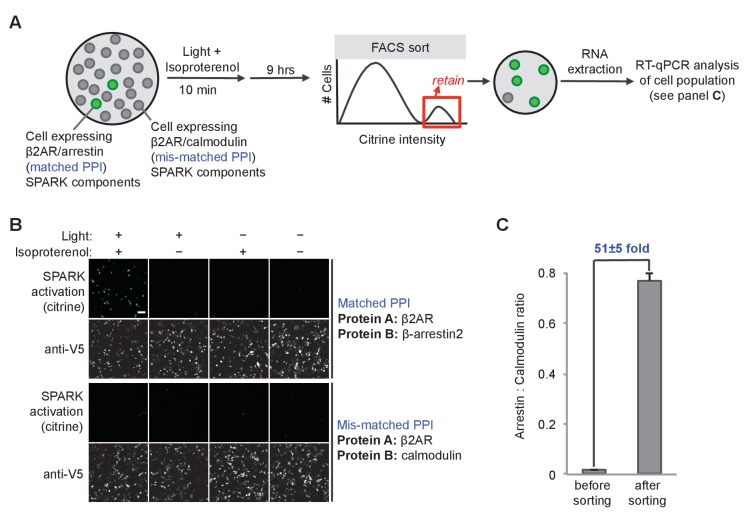
SPARK can be coupled to genetic selections.(A) Selection scheme to enrich cells with PPI (protein-protein interaction) event during time window of interest over cells without PPI event. Culture dish containing mixed population of cells. Protein A (the ‘bait’) remains constant in the SPARK TF component, but protein B (‘prey’) varies in the SPARK protease component. In our model selection, we used β-arrestin2 as the matched prey (interacts with β2AR), and calmodulin as the mis-matched prey (does not interact with β2AR). The culture dish is subjected to light and β2AR-stimulating ligand isoproterenol for 10 min, then cultured for an additional 9 hr. FACS sorting is performed to isolate cells with high Citrine expression, indicative of SPARK activation. After sorting, the cell population is expected to be strongly enriched in β-arrestin2-expressing cells over calmodulin-expressing cells. (B) Imaging of HEK293T cells expressing SPARK components with matched bait + prey (top) versus mismatched bait + prey (bottom). Images were acquired 9 hr after stimulation with 10 μM isoproterenol and light (daylight lamp, 25W, 6500K, 480 nm/530 nm/590 nm). Anti-V5 antibody stains for the SPARK β2AR TF component. Scale bar, 100 μm. (C) RT-qPCR analysis of mixed cell population before and after FACS sorting. RNA was extracted from cells and reverse transcribed, and arrestin-TEVp:calmodulin-TEVp ratios were quantified by qPCR. Pre-sort ratio is 1:66; post-sort ratio is 1:1.3. Data represent the mean of three replicates. Error bar, ±STD.